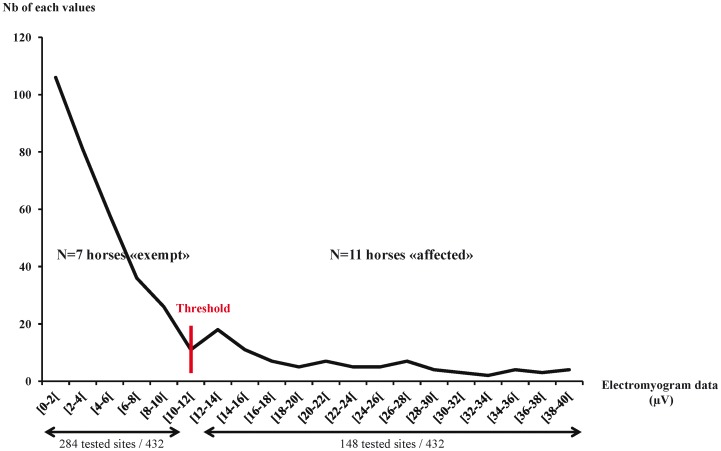
Distribution of sEMG measures across the number of tested sites concerned and threshold value.All sEMG data of the population were pooled (N = 2 groups, 18 horses × 12 tested sites × 2 sides of the spine).